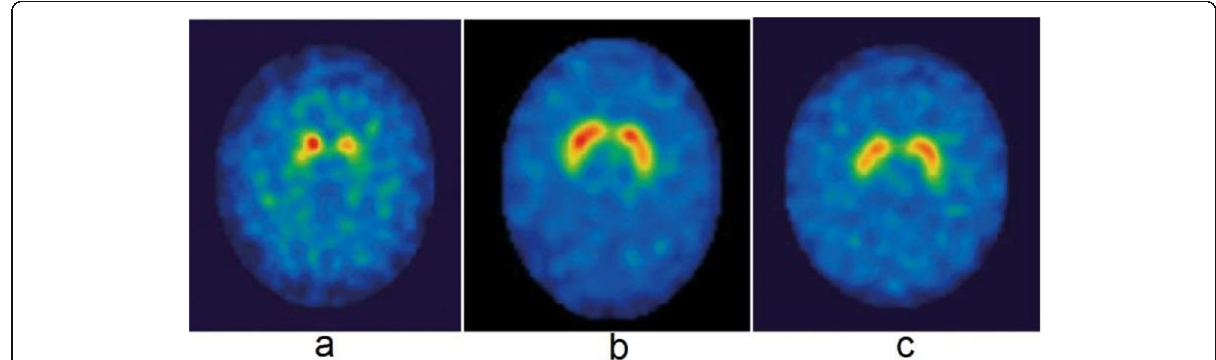
Fig. 4 Dopamine transporter imaging by administration of 123 I-fluopane (FP)-CIT in a patient with Parkinson ’ s disease ( a ), an essential tremor ( b ), and a healthy control ( c )